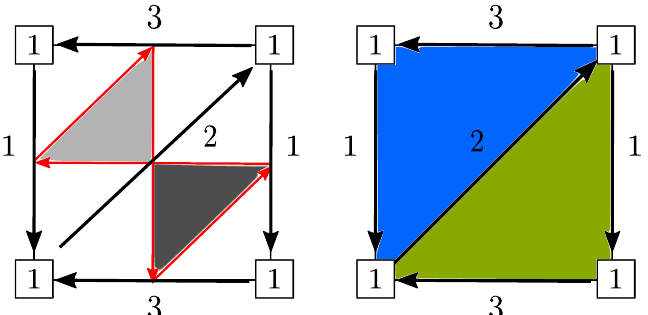
Figure 13. Q 0 , Q 1 , Q 2 of the C 3 geometry. There is only one vertex here, Q 0 = { 1 } . The set of arrows connecting vertices are Q = { 1 1 −→ 1 , 1 2 −→ 1 , 1 3 −→ 1 } . Since we are considering the 1 torus, which means we are identifying the boundaries, the vertices and edges on the boundaries are identified. We have two elements of Q and they are the blue and green region. They are 2 identified with the closed loop of arrows 1 1 −→ 1 2 −→ 1 3 −→ 1 and 1 3 −→ 1 2 −→ 1 1 −→ 1 respectively.